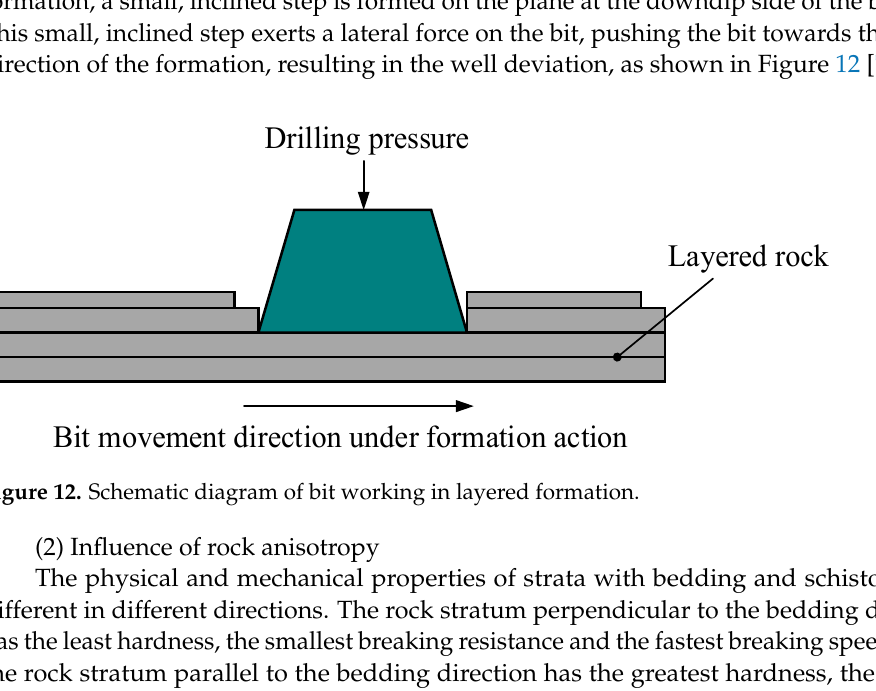
Figure 13. Hole breakage of bit and formation in different directions. ( a )—The bit is perpendicular to the layer; ( b )—The bit is oblique to the layer; ( c )—The bit is parallel to the layer. 1—Crushing speed perpendicular to the layer; 2—Crushing speed at oblique intersection with the layer; 3— Crushing speed parallel to the layer. Figure 13a shows the hole breakage of the bit and the formation in different direc- tions. In Figure 13b, the drill bit is oblique to the formation surface, and the drill bit is subject to a force from the dip direction of the formation—the formation deflecting force, which makes the drill bit axis force deflect to the direction perpendicular to the formation surface, and the drill hole is elliptical. In Figure 13c, due to the low hardness perpendicular to the layer, the rock on the hole wall is easily broken, the hole diameter formed is large, and the hole wall gap is large, which makes the bit stability poor, and the hole is also easily bent. (3) Influence of soft and hard interlaced strata [74] The influence of the drill bit on the bending of the hole when it passes through the soft and hard interbedding depends on the angle δ of contact of the hole axis ( δ refers to the residual angle between the borehole axis and the normal of the rock layer) and the